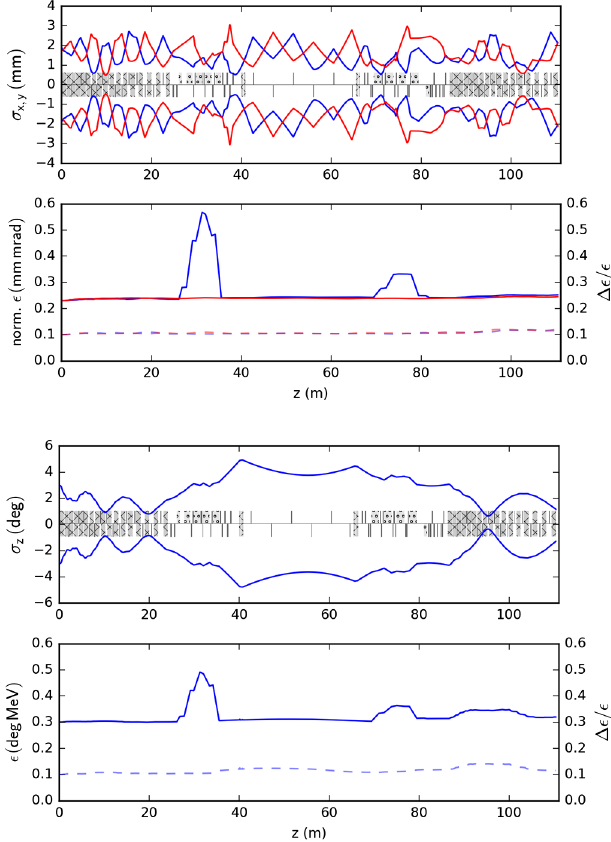
FIG. 19. rms beam statistics from the first-pass LINAC entrance to the second-pass LINAC exit for 40 mA bunch current and waterbag initial